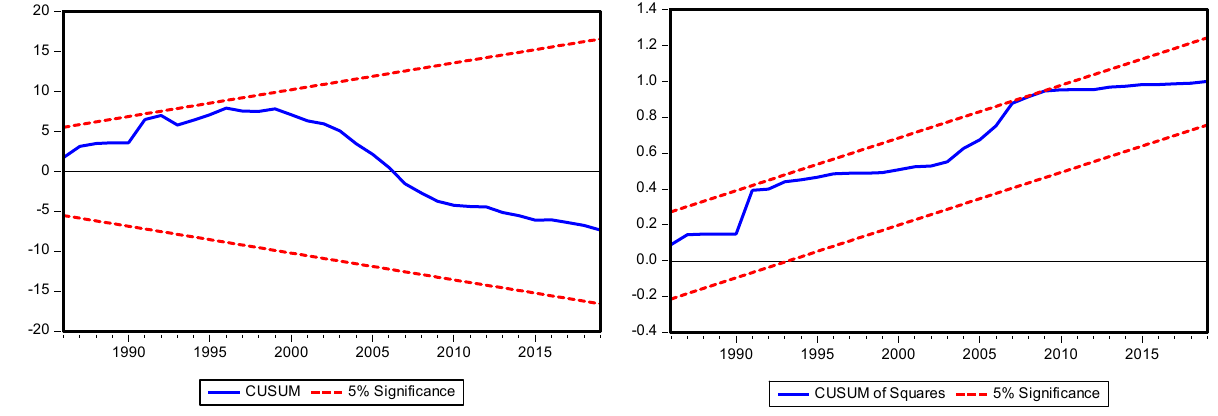
Figure 2. Stability test of the